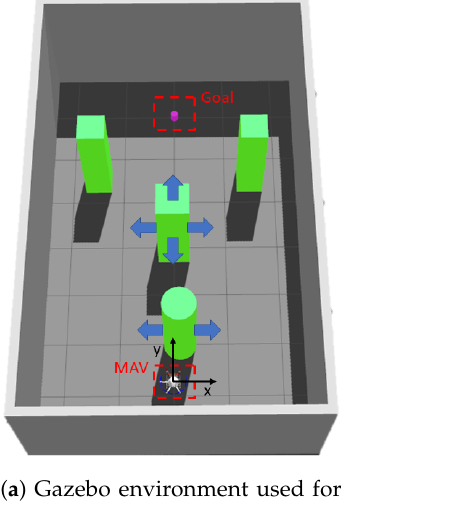
( b ) Example result of the trajectory generated by the only forward mode of the proposed collision- avoidance method.